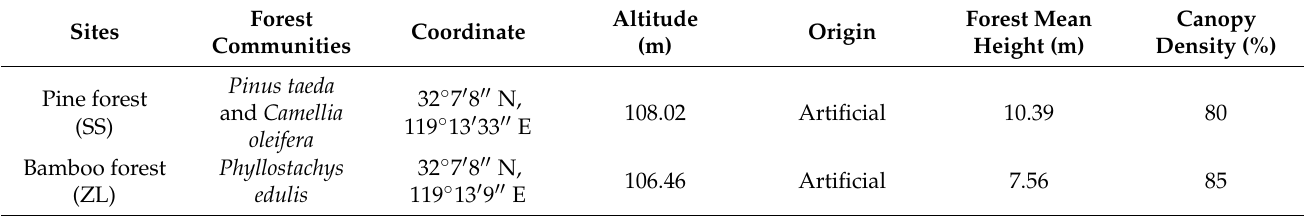
Table 1. The basic situation of the two